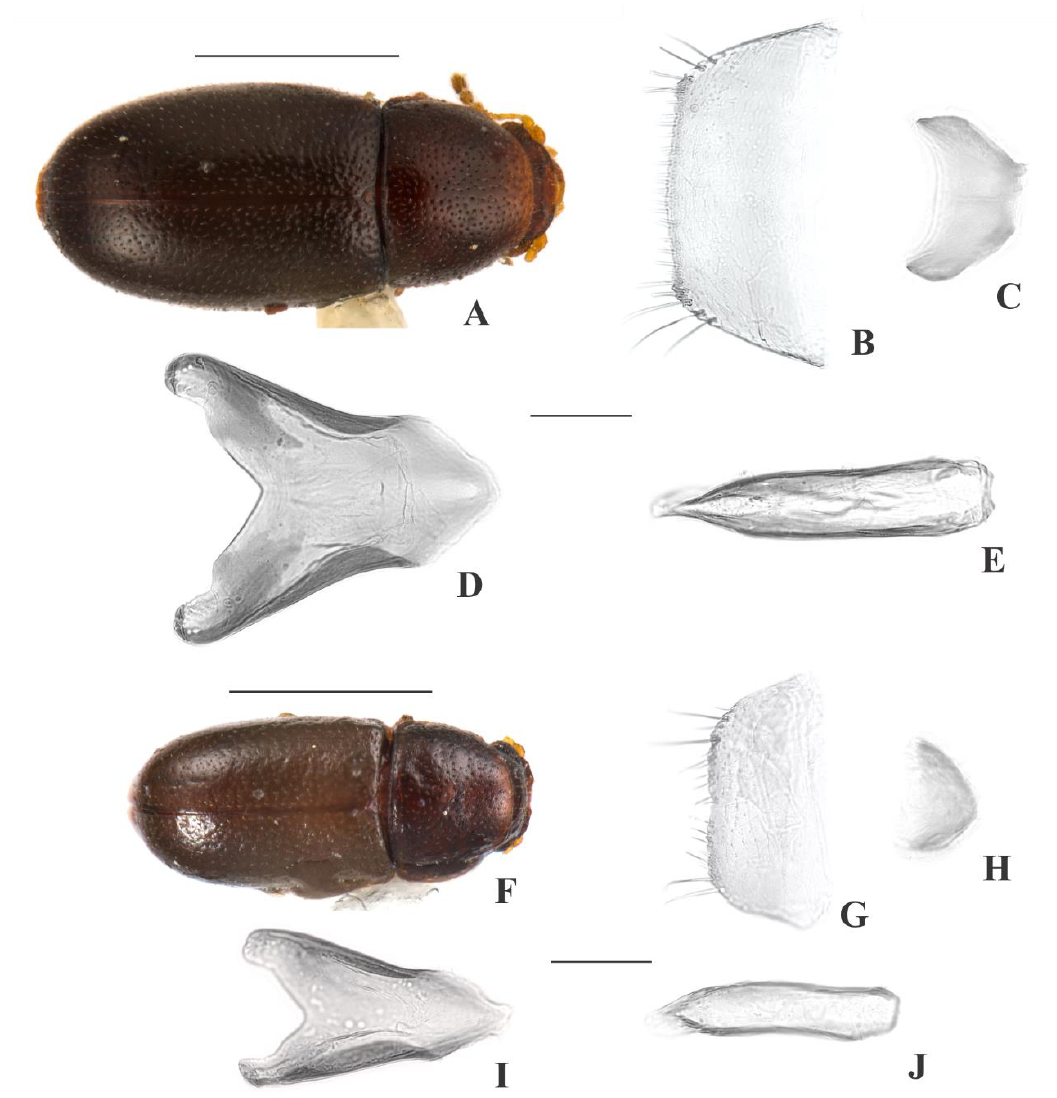
Figure 9. Variation between populations of Cis parvisetosus sp. n. , male and aedeagus of paratype from Prince Alfred’ S Pass (A–E), male and aedeagus of paratype from Mpisini Nature Reserve (F–J): A and F. Dorsal view. B and G. Sternite VIII. C and H. Basal piece. D and I. Tegmen. E and J. Penis. Scale bars: 0.5 mm (A, F ), 0.05 mm (B–E, G–J).